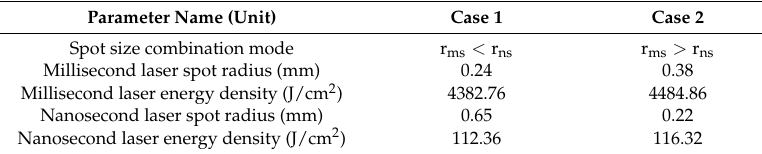
Table 1. Millisecond-nanosecond combined-pulse laser parameters variable control.